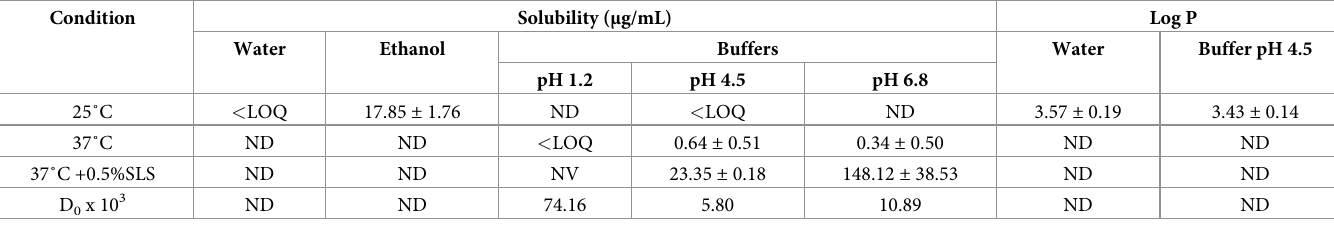
Solubility and partition coefficient presented as mean ± SD; < LOQ refers to less than 0.05 μ g/mL; ND, not determined; NV, not valid because more than 10% of hydrolytic products of CUR-2GE was observed (S1 Table).